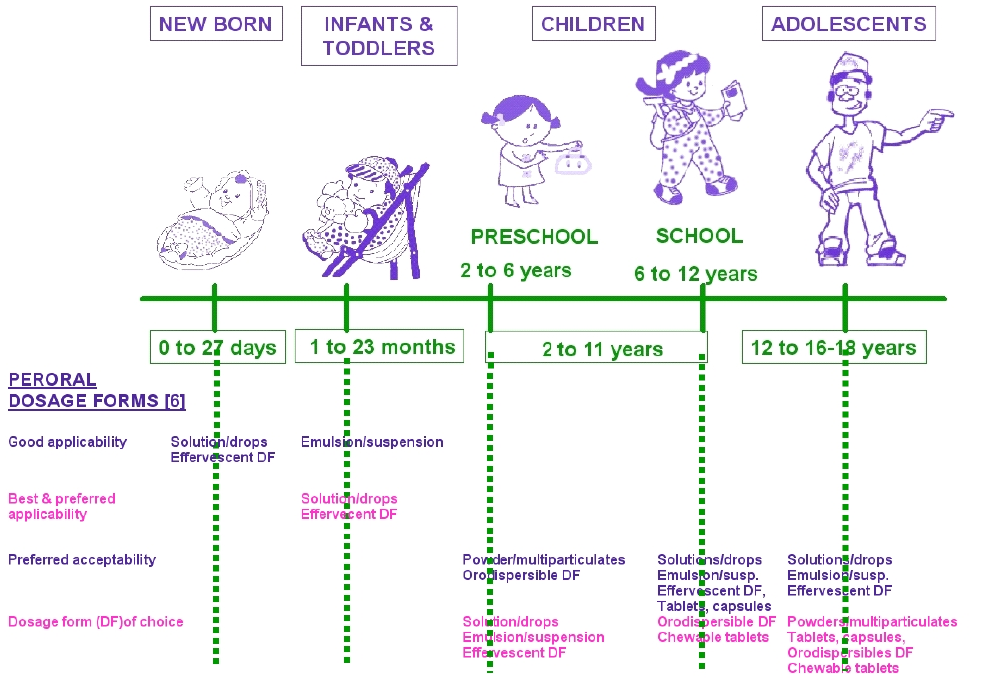
Figure 1. Age groups within the pediatric population and indication of peroral dosage forms applicability and preferences per age